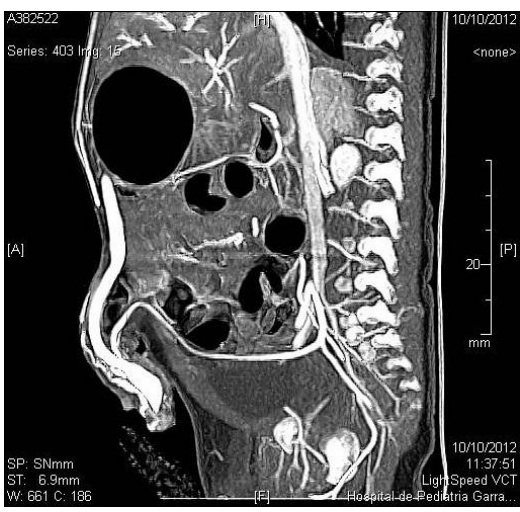
Figure 3: Umbilical arteries arising from both internal iliac arteries, flowing into the mass directly at the end of the umbilical cord.